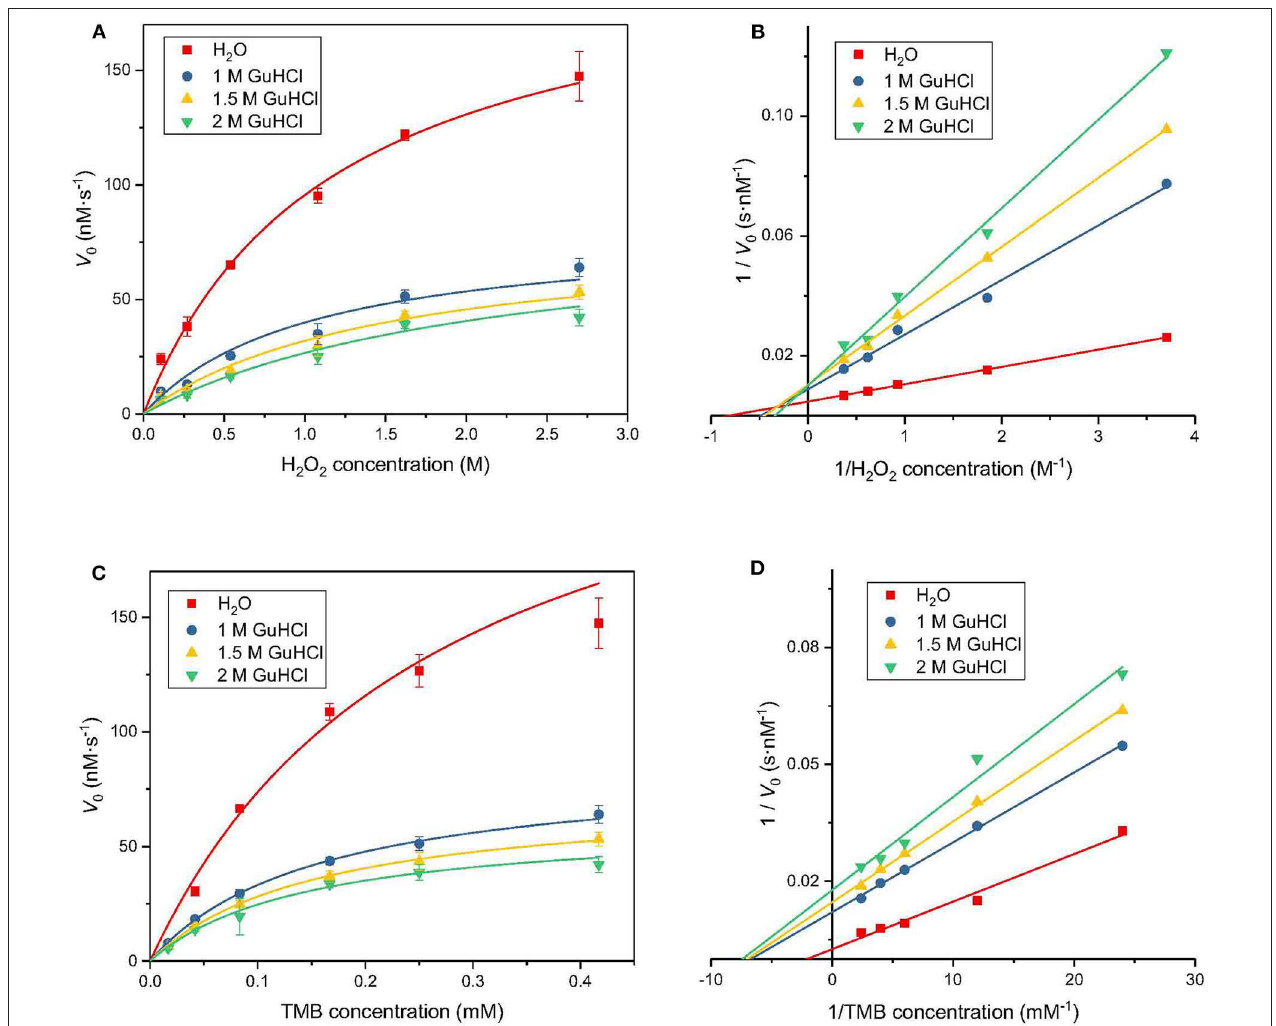
FIGURE 3 | Inhibition kinetics analysis of IONzyme at different GuHCl concentrations. Conditions are shown in Figure 1 , except that K m , V max , k cat , and k cat / K m were analyzed at different H 2 O 2 concentrations (A) . The Lineweaver-Burk plot of the data from (A) is shown in (B) . The data for different concentrations of TMB are shown in (C) and the Lineweaver-Burk plot of the data from (C) are in (D) . Data from 3 separate experiments ( n ≥ 8). Data are the mean ± SD.